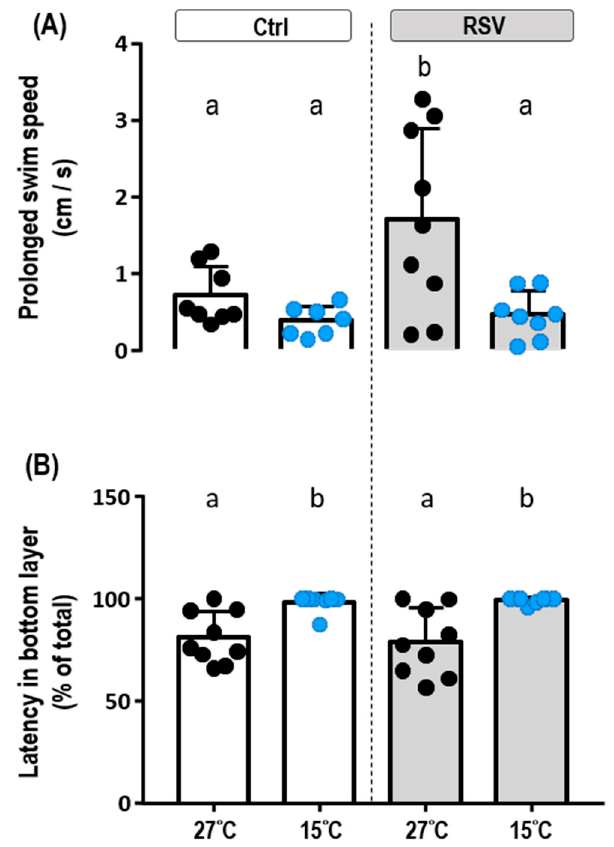
Figure 4. Effects of the Ctrl and RSV-diet on behavior of tilapia at 27 °C and 15 °C. The locomotor activities of fish fed with Ctrl and RSV-diets were estimated by the prolonged swim speed ( A ) and the latency time in the bottom layer ( B ) of juvenile tilapia in a novel tank assay under 27 °C and 15 °C conditions. Black dots and white columns represent the Ctrl-diet group at 27 °C. Blue dots and white columns represent the Ctrl-diet group at 15 °C. Black dots and gray columns represent the RSV-diet group at 27 °C. Blue dots and gray columns represent the RSV-diet group at 15 °C. Data are presented as mean ± SD ( n = 8 or 9). Different letters indicate significant differences ( p < 0.05) among different groups (Two-way ANOVA and Tukey’s HSD).